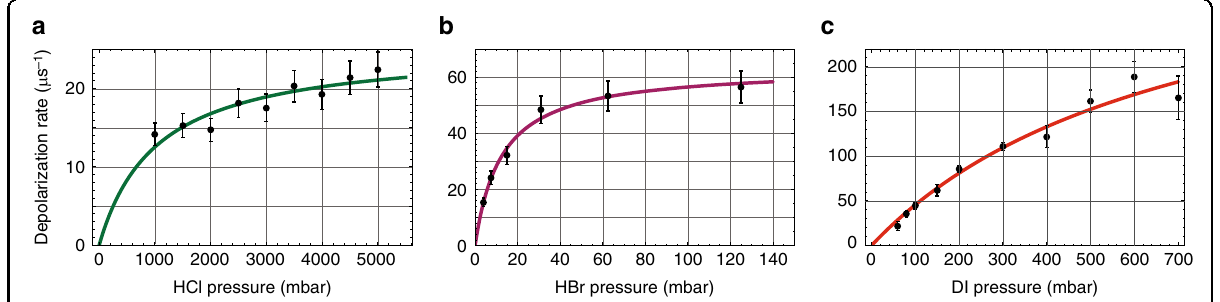
Fig. 5 SPH depolarization rates. Measurements of the SPH depolarization rate as a function of hydrogen halide pressure 35 for ( a ) HCl, ( b ) HBr, and ( c ) DI. The data are fi t using Eq.